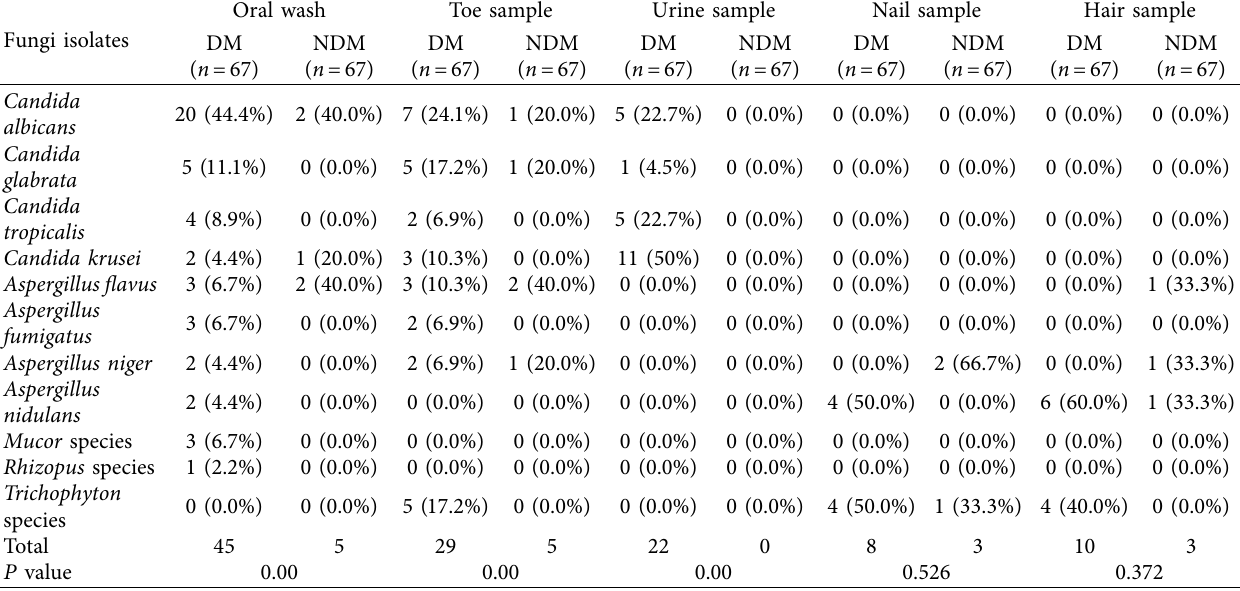
Table 1: Prevalence of fungi in diabetic and nondiabetic individuals from different samples.